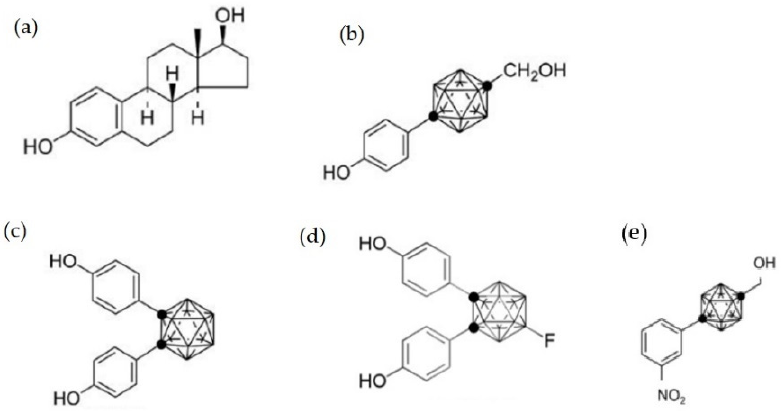
Figure 3. The chemical structure of: ( a ) 17 β -E2; ( b ) BE120; ( c ) BE360; ( d ) BE310; and ( e ) BA321.